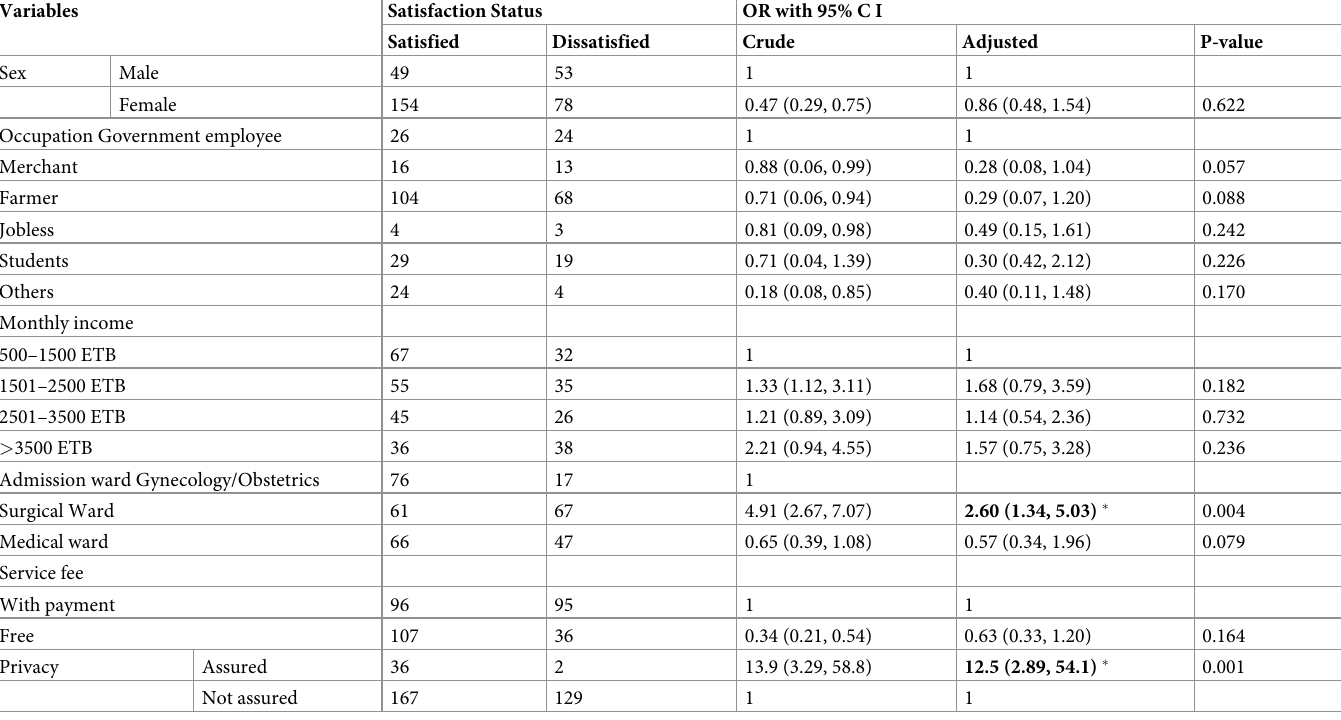
Table 3. Bivariable and multi-variable analysis of factors associated with satisfaction among patients admitted to Pawie General Hospital, West Ethiopia,